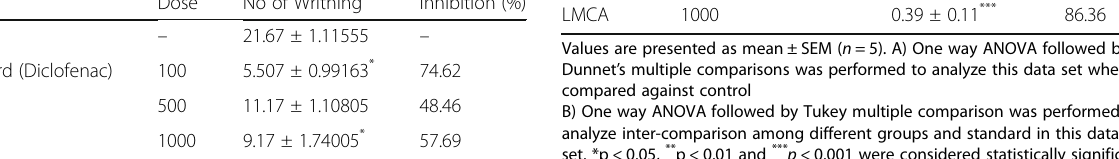
Table 4 Effect of LMCA in Acetic Acid Induced Writhing test Group Dose No of Writhing Inhibition (%) Control